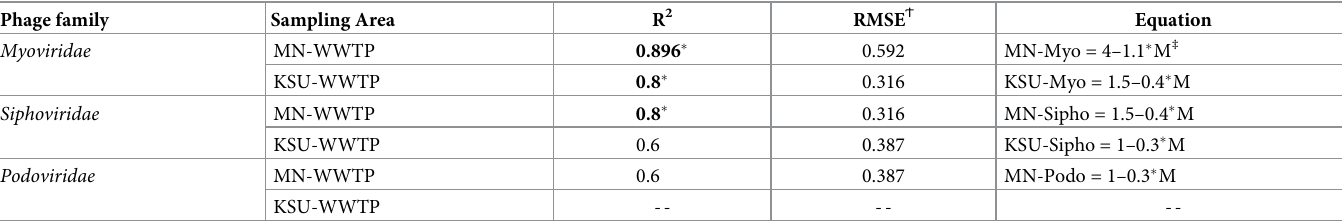
Table 2. The significance of the influence of temperature on prevalence of phage families in wastewater treatment plants.